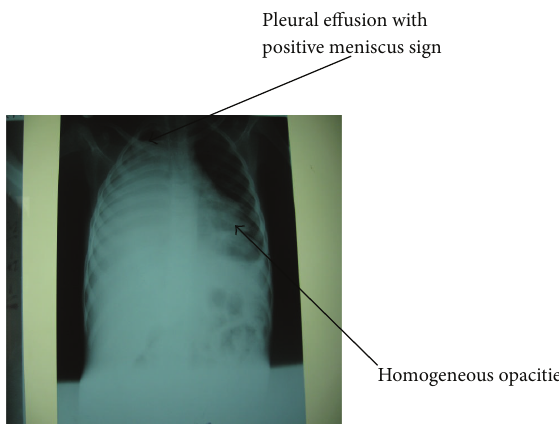
Figure 1: A picture of the child showing empyema necessitans. symptoms and the past medical history was not significant.